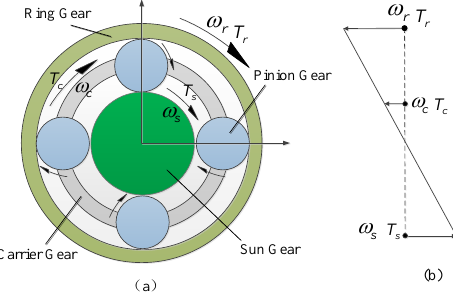
Figure 3. Structure of planetary gear (PG): ( a ) PG; and ( b ) its level diagram analogy.